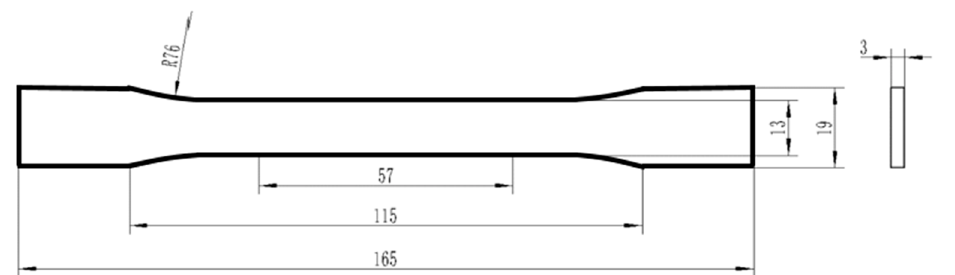
Figure 2. Specimen dimensions for tensile and fatigue tests.